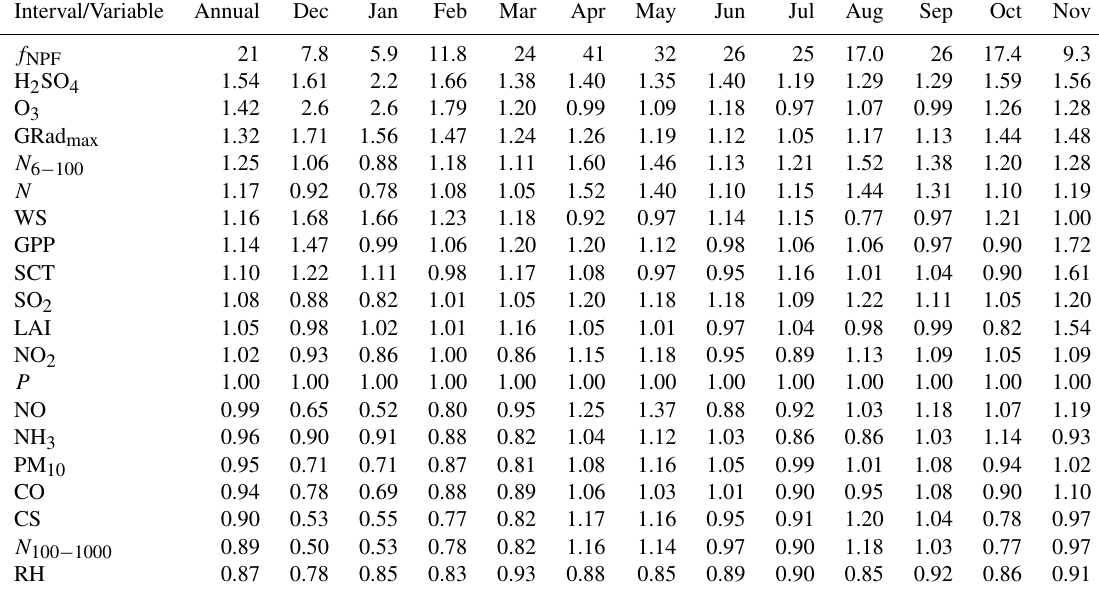
Table 2. Overall mean relative occurrence frequency of NPF event days ( f NPF , in percent) and overall mean event-day-to-non-event-day ratios for the daily median concentration of gas-phase H 2 SO 4 and O 3 , daily maximum global solar radiation (GRad max ), N 6 − 100 , N , wind speed (WS), gross primary production (GPP) of vegetation, stomatal conductance (SCT), SO 2 , leaf area index (LAI), NO 2 , atmospheric pressure ( P ), NO, NH 3 , PM 10 mass, CO, condensation sink (CS), N 100 − 1000 , and relative humidity (RH) for each month and for all data in the city centre. The ratios were organised in descending order of their annual mean values (the first data